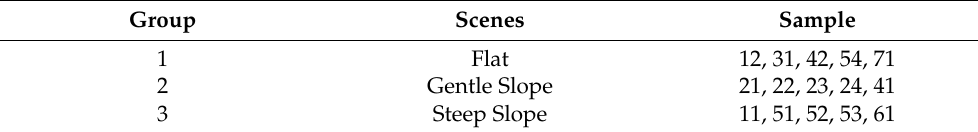
Table 2. Sample areas grouping based on geomorphological features.